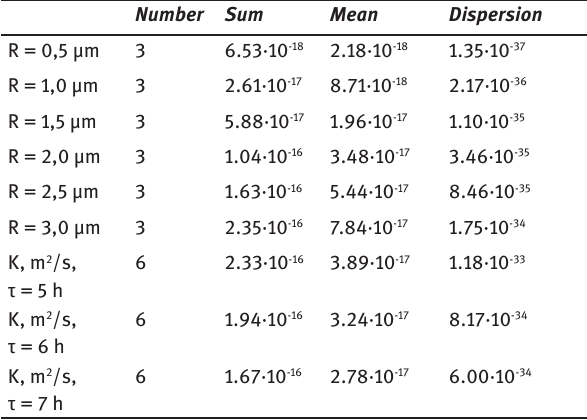
Table 5: Dispersion analysis.